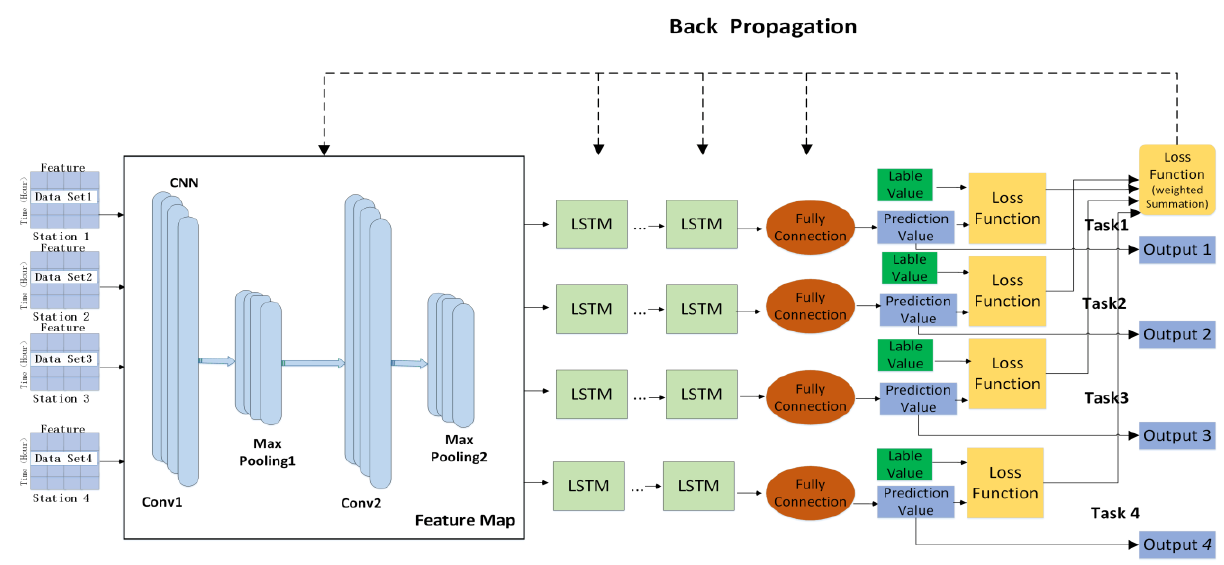
Figure 2. MTL-CNN-LSTM prediction model structure.